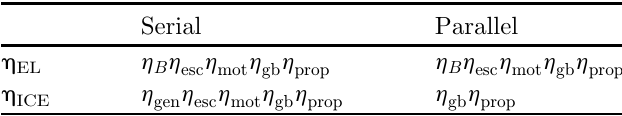
Table 3. Comparison between the ATR42-600 and the test con fi guration aircraft in case of